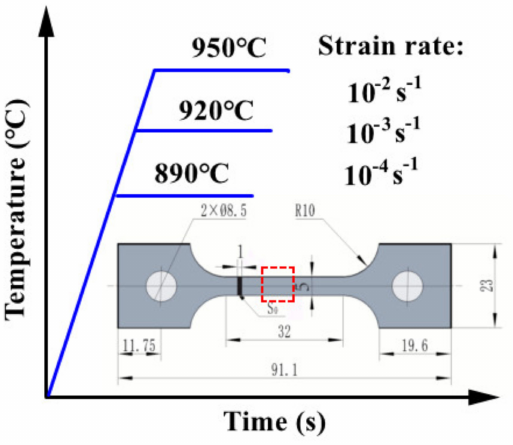
Figure 1. The dimensions of the tensile test